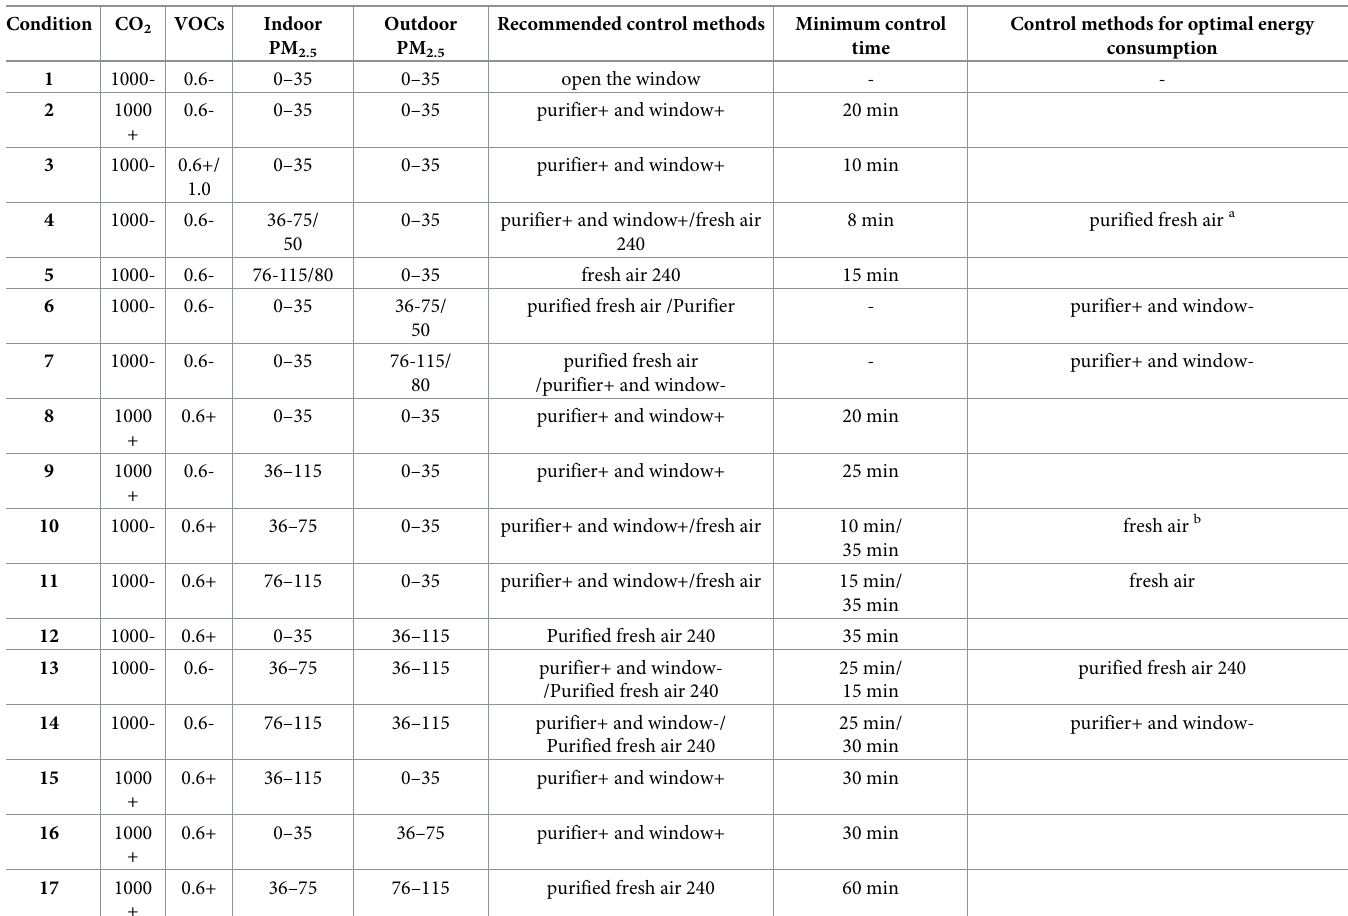
Table 5. Recommended control